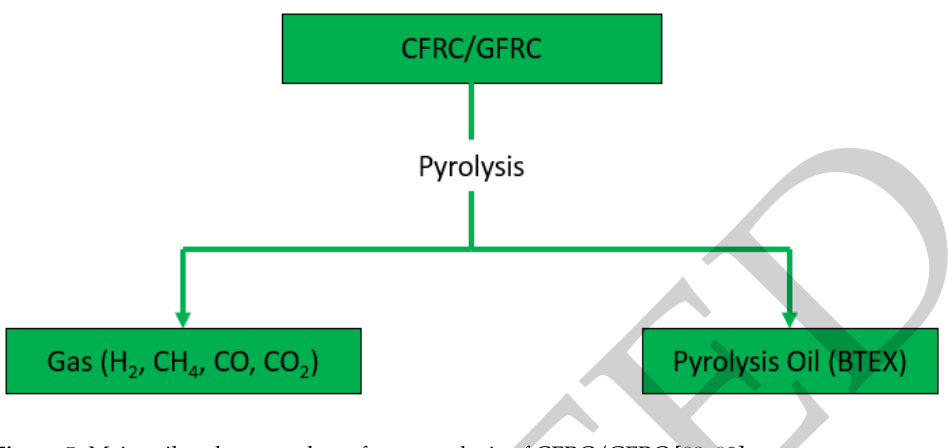
Figure 5. Major oil and gas products from pyrolysis of CFRC/GFRC [88–92].